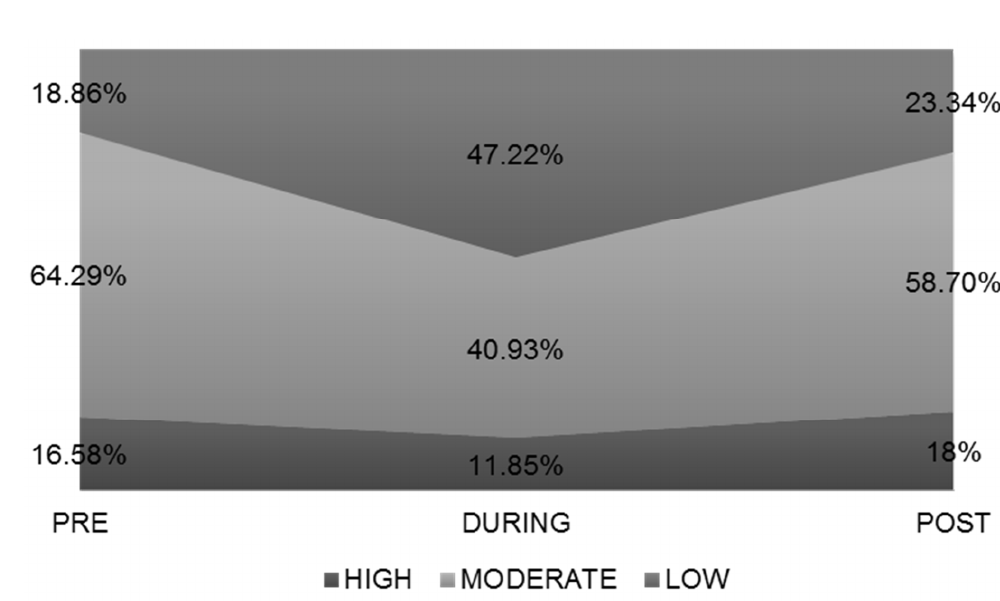
Figure 4. Level of morning alertness (categories). Table 5. Morning alertness of the study population.